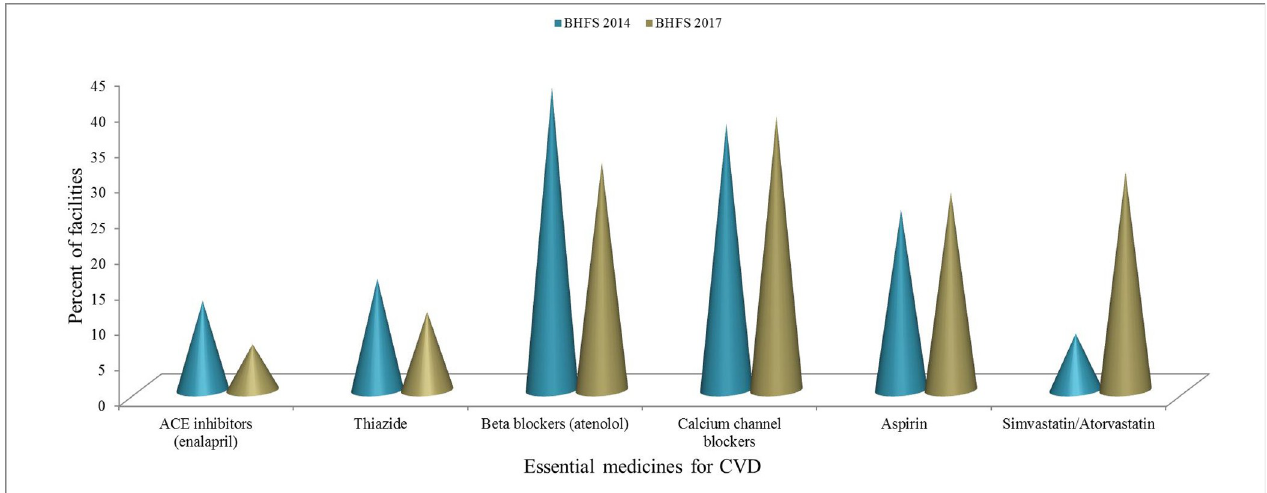
Fig 3. Availability of essential medicines for CVD at health facilities in Bangladesh, BHFS 2014 and 2017.